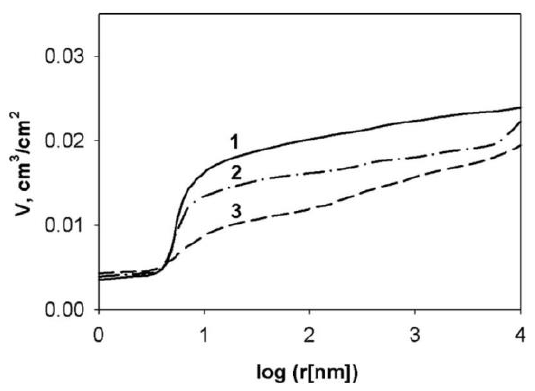
Figure 24. Integral porograms for air cathodes before discharge (curve 1), after partial discharge of 48% at 0.25 mA/cm 2 (curve 2), and after full discharge at 0.25 mA/cm 2 (curve 3). Republished from Nimon et al. [30] with permission of The Electrochemical Society conveyed through Copyright Clearance Center, Inc.